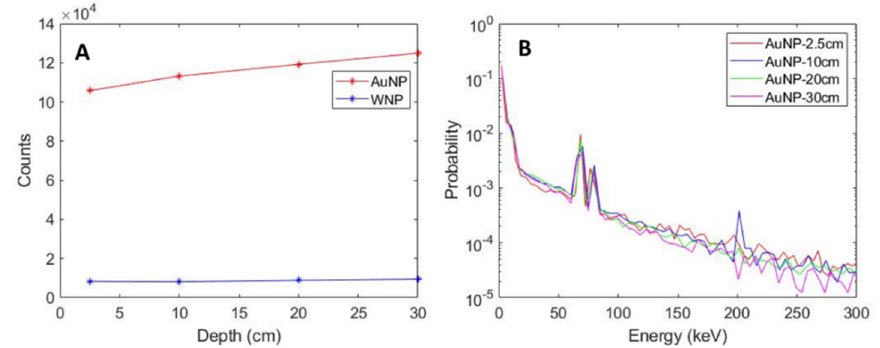
Figure 7. Secondary particle count and energy spectrum at various depths collected on phsp3. ( A ) shows the secondary particle counts for both the AuNP and the water nanoparticle (WNP). ( B ) shows the energy spectrum of secondary particles of AuNP. Table 3. Spectrum characteristics of secondary particles emitted from AuNPs located at different depths, with the same number of incident photons.